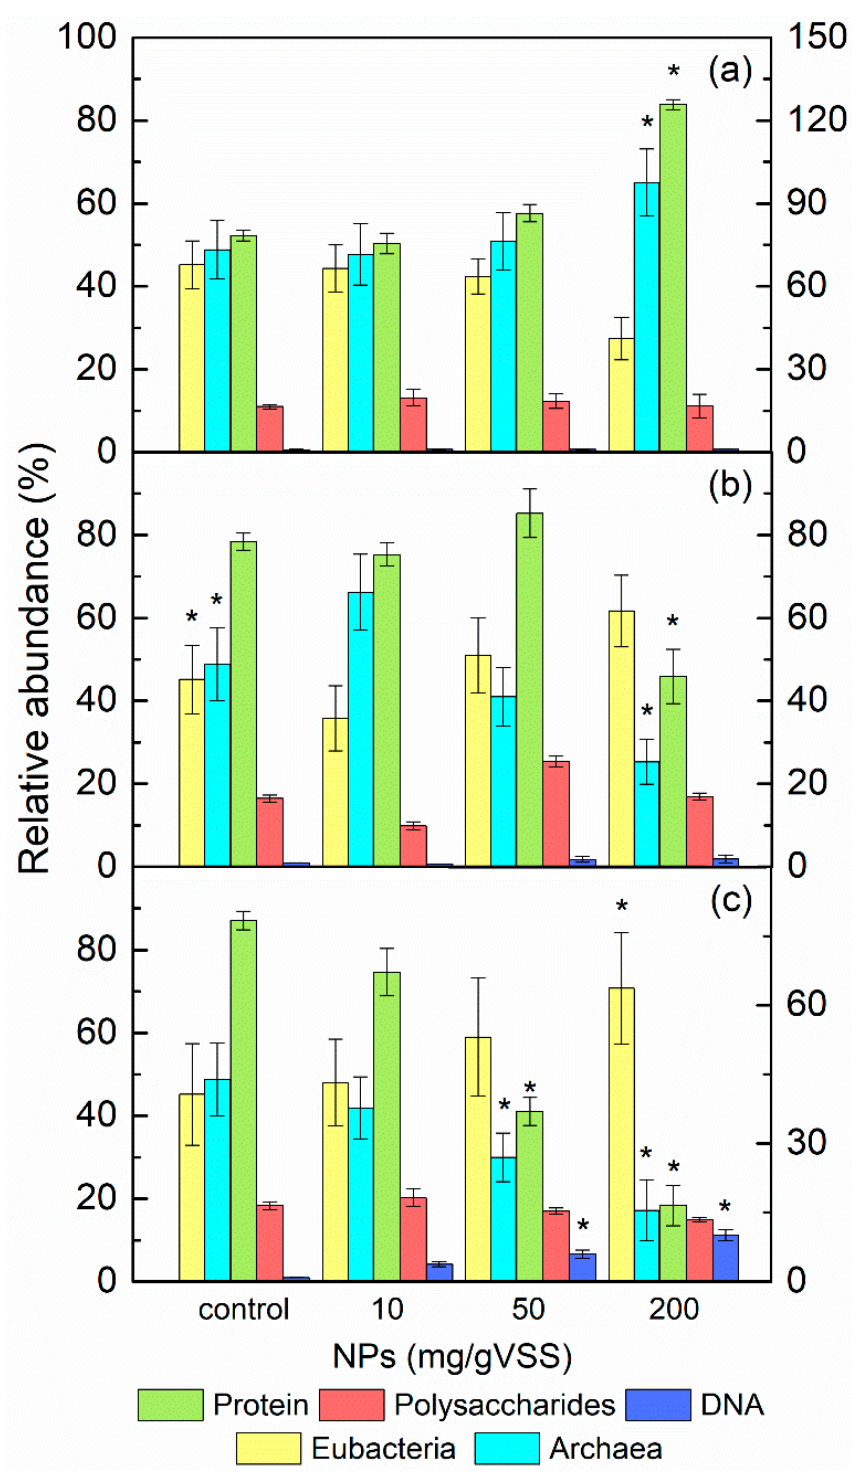
Figure 4. Comparisons of the microbial community structure and EPS compositions in AGS after TiO 2 ( a ), ZnO ( b ), and CuO ( c ) NPs’ exposure. * Error bars of the relative abundance and EPS content represent standard deviations of the triplicate slot blot hybridizations and triplicate measurements, respectively. Asterisks indicate statistically significant differences ( p < 0.05) from the control.